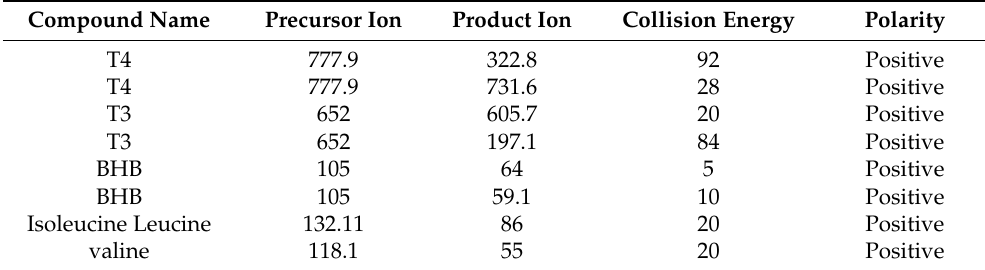
Table 1. List of precursor and product ions with collision energy and polarity measured by LCMSMS in this